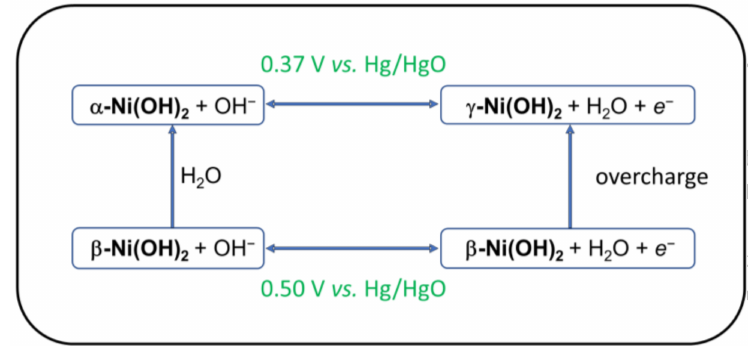
Figure 1. Bode cycle indicating electrochemical phase changes for Ni(OH) 2